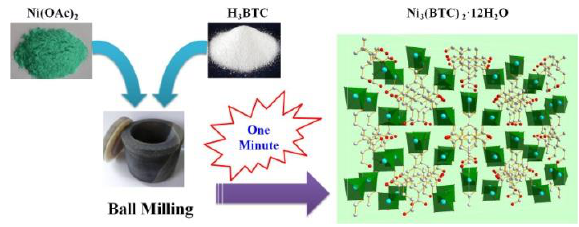
Figure 1. Schematic representation of the ball milling method for the rapid synthesis of Ni - MOF .